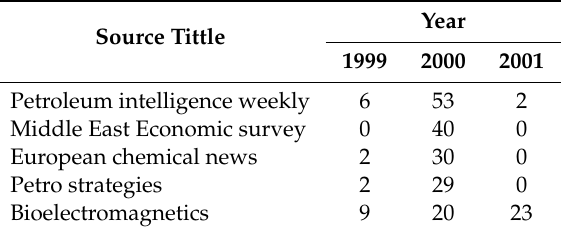
Table 2. Main contributions in 2000 of total ELF